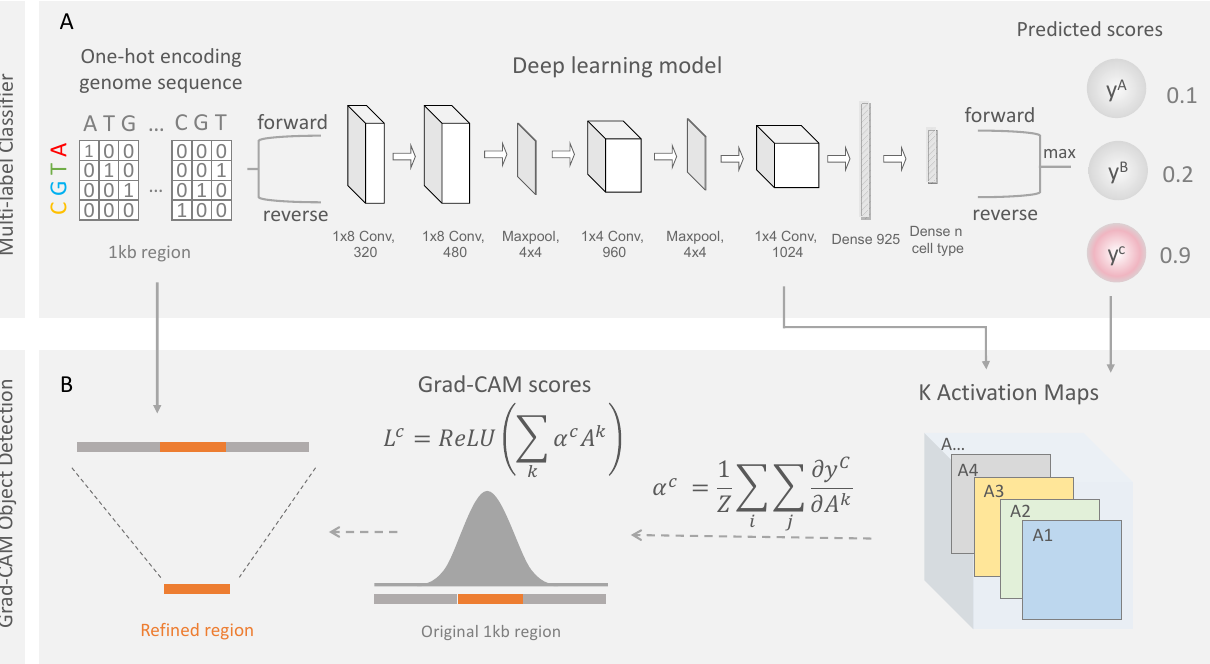
Figure 2. Details of the multi-label classifier module and object detection module. ( A ) An input sequence is first one-hot encoded into a 4-row bit matrix. Both the forward and reverse strands are fed into the CNN deep learning model. The architecture is composed of four convolutional layers, two polling layers, and two dense layers. The output is the sigmoid probability of each peak’s accessibility for each cell type. ( B ) For each positive prediction, we can use the Grad-CAM object detection module to refine the peak boundaries and localize the important non-coding regions. By superimposing activation maps ( A k ), weighted by an importance score ( α c ), the object detection module highlights the most salient sub-regions in making the final accessible